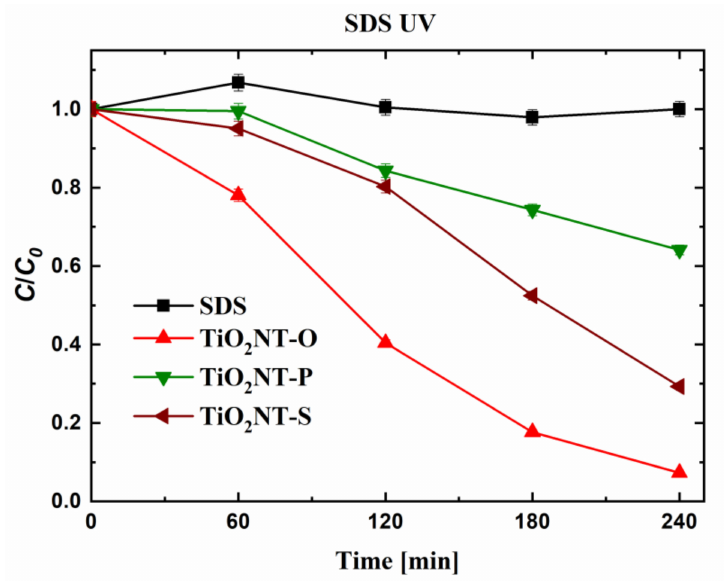
Figure 7. Degradation efficiency of nanotube arrays towards sodium dodecyl sulfate (SDS) after irradiation with UVA light.